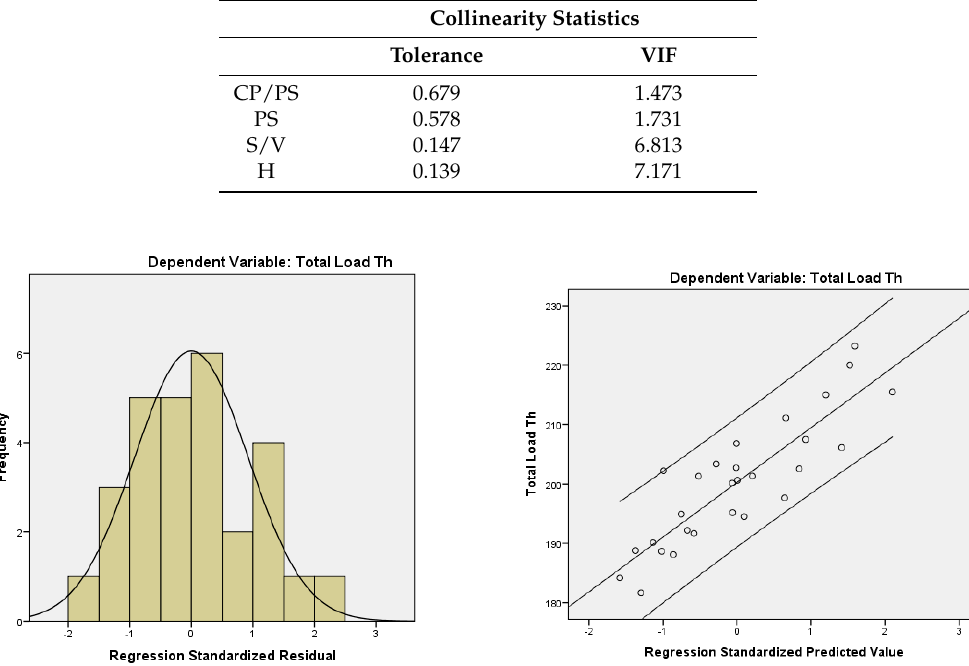
Figure 12. Statistical tests for Thessaloniki’s regression model.